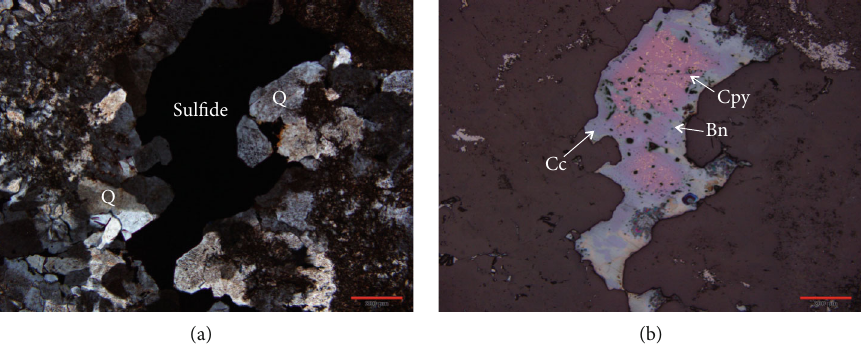
Figure 5: Microphotographs of ore minerals including chalcopyrite, bornite, and chalcocite under (a) transmitted light and (b) re fl ected polarized light. The scale bar is 200 μ m. Cpy: chalcopyrite; Bn: bornite; Cc: chalcocite; Q: